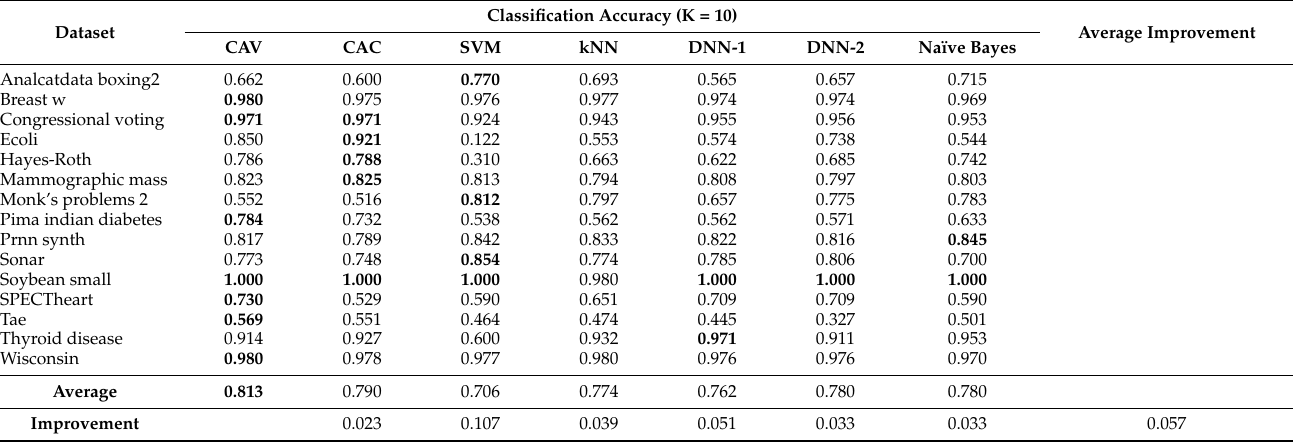
Table 7. The F1 of the proposed CAV compared with CAC, SVM, k-NN, DNN-1, DNN-2 and naïve Bayes (the bold number indicates the maximum